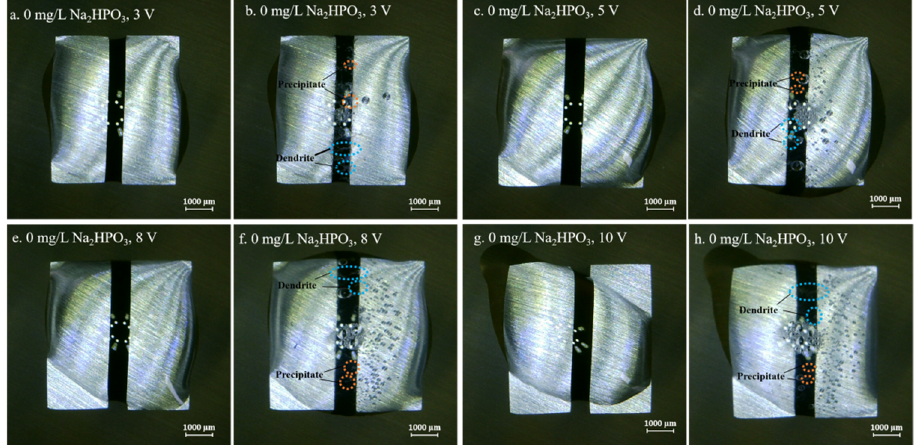
Figure 4. Optic photos for ECM tests of tin under a droplet of 15 μ L containing 0 mg/L Na 2 HPO 4 at various bias voltages (Anode is on the left and cathode is on the right).